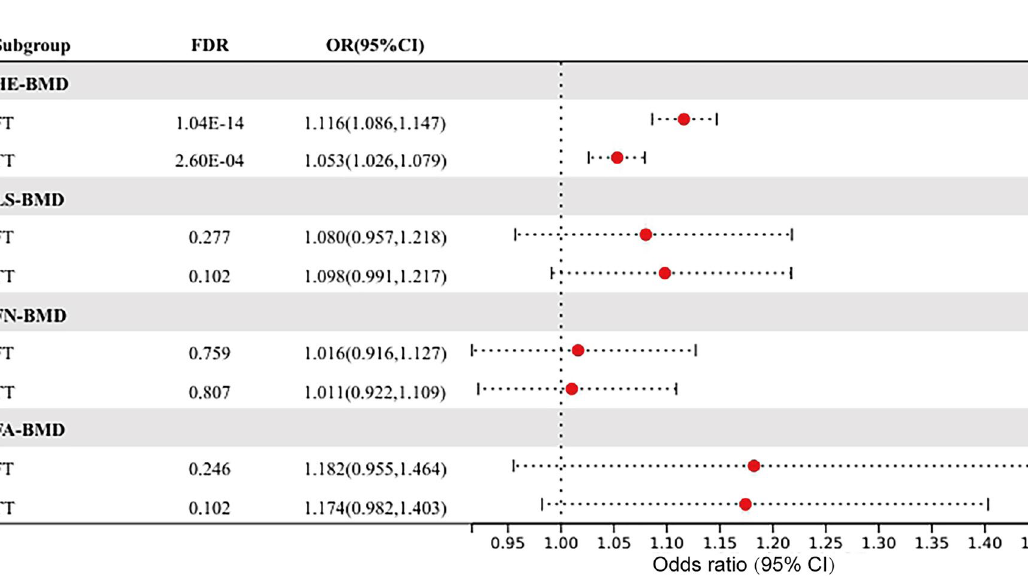
Figure 3. The forest plot of Mendelian randomization results between testosterone levels and bone mineral density at different sites.